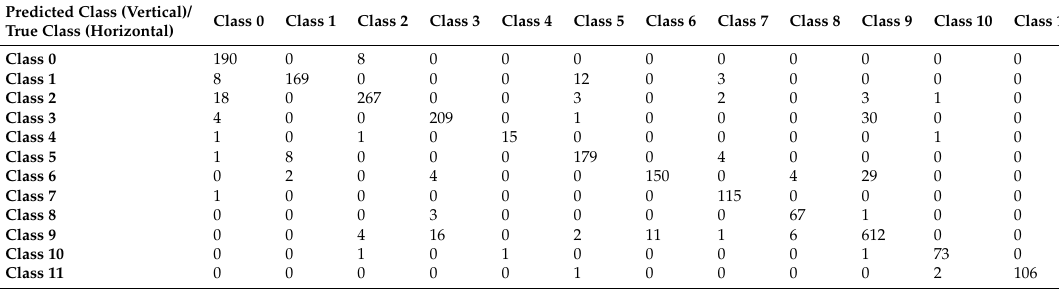
Table 11. Confusion matrix